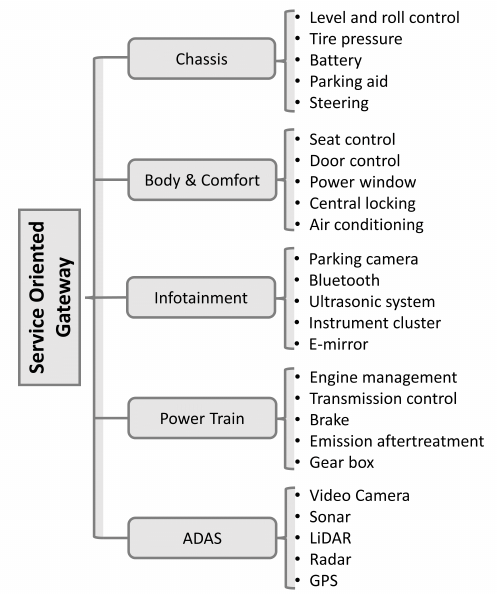
Figure 1. Vehicle domain